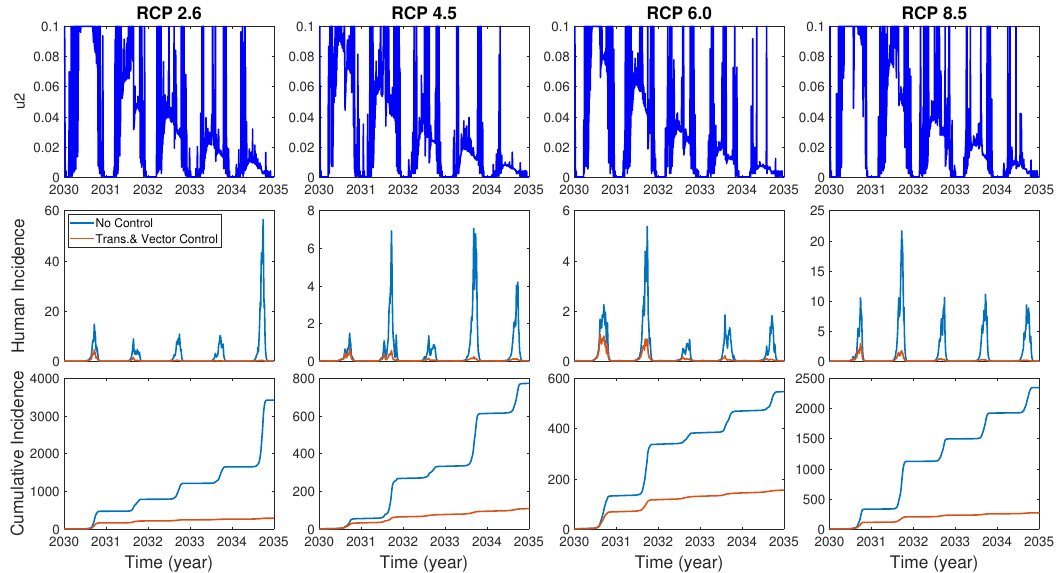
Figure 8. The effect of control of the mortality rate µ v on the incidences and the optimal control function u 2